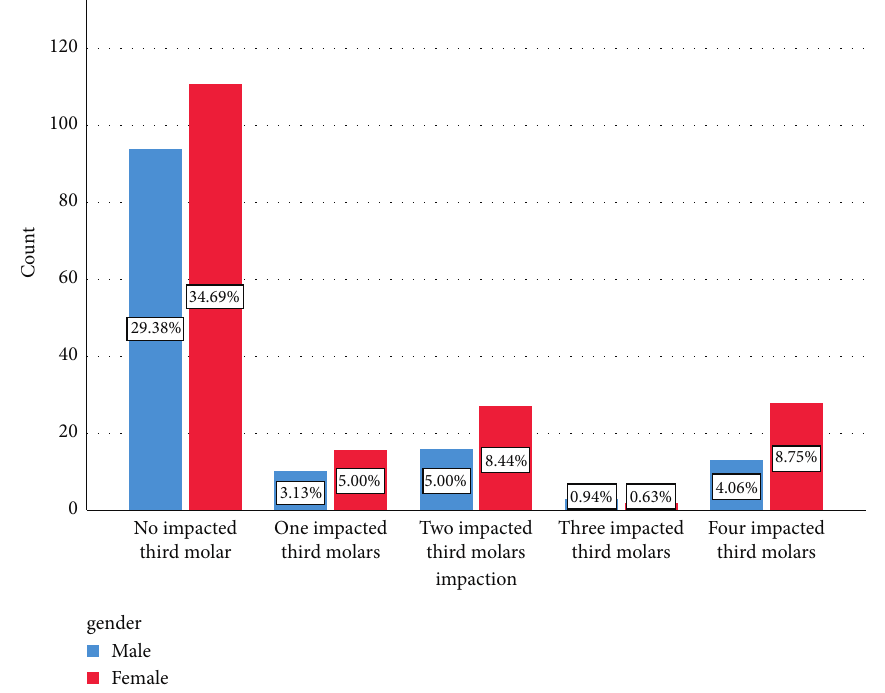
Figure 1: Frequency distribution of the impacted third molar and Table 2: Frequency of the impacted third molar in blood types.